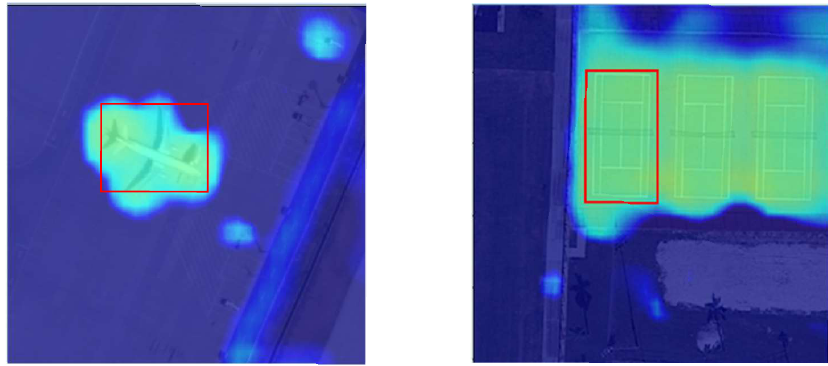
Figure 4. The location maps of plane ( left ) and tennis court ( right ).